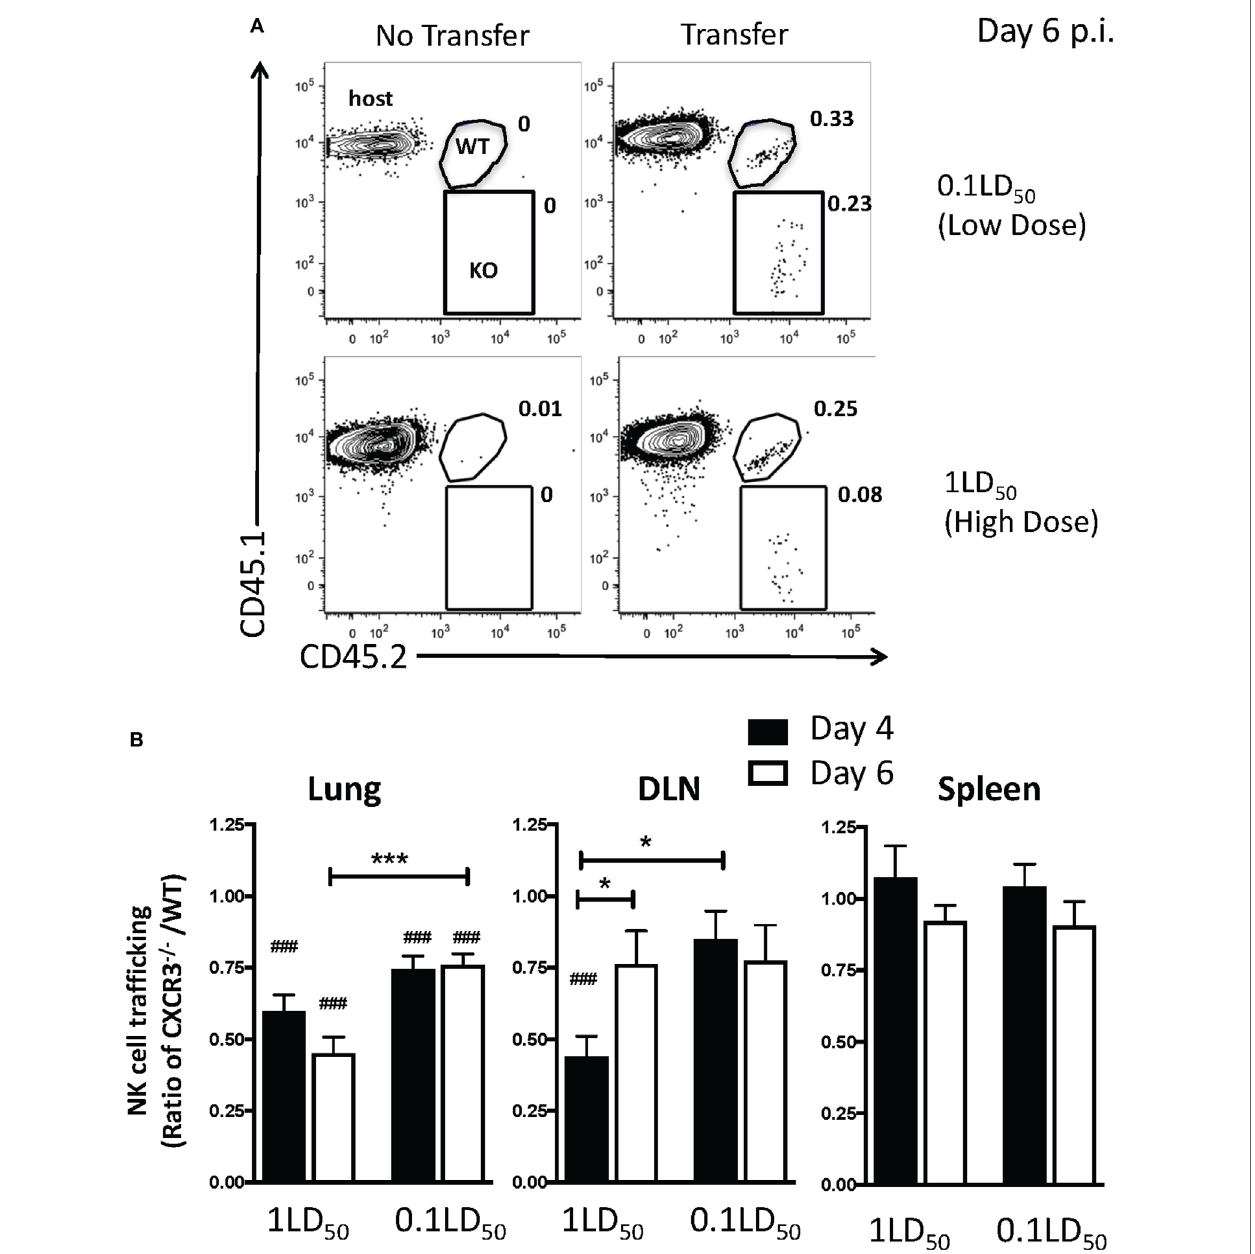
FigUre 5 | CXCR3 expression by natural killer (NK) cells increases NK cell trafficking to the lung and draining lymph node (DLN) during influenza A virus (IAV) infection. C57Bl/6 (CD45.1) host mice were infected with a high or a low dose of IAV. 5 × 10 5 donor WT C57Bl/6 (CD45.1/CD45.2) and 5 × 10 5 CXCR3 − / − (CD45.2) NK cells were transferred into infected host mice for 16–18 h before analysis. (a) Representative flow plots for NK cells (NK1.1 + CD3 ε − ) on day 6 post infection (p.i.) in high- or low-dose IAV lungs showing host (CD45.1 + CD45.2 − ), WT donor (CD45.1 + CD45.2 + ), and CXCR3 − / − donor (CD45.1 − CD45.2 + ) NK cells. (B) The normalized ratio of CXCR3 − / − NK cells to WT NK cells in the lungs, DLN, and spleen of infected recipients is shown. Note: equal trafficking between WT and CXCR3 − / − NK cells = 1. p -values comparing WT to CXCR3 − / − NK cell trafficking (two-tailed paired Student’s t -test) within the same group are shown. # p < 0.05, ### p < 0.001, and comparing, as indicated, the CXCR3 − / − NK cells:WT NK cell ratio between high- and low-dose IAV-infected mice or by time post infection. * p < 0.05, *** p < 0.001. Data are pooled from two high-dose experiments and three low-dose experiments, with five mice per group.